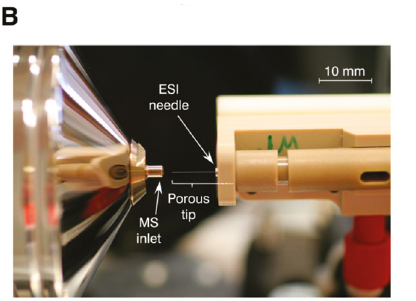
Figure 4 The porous sheathless interface (A) schematic and (B) photograph of the prototype interface. Reprinted with permission from reference